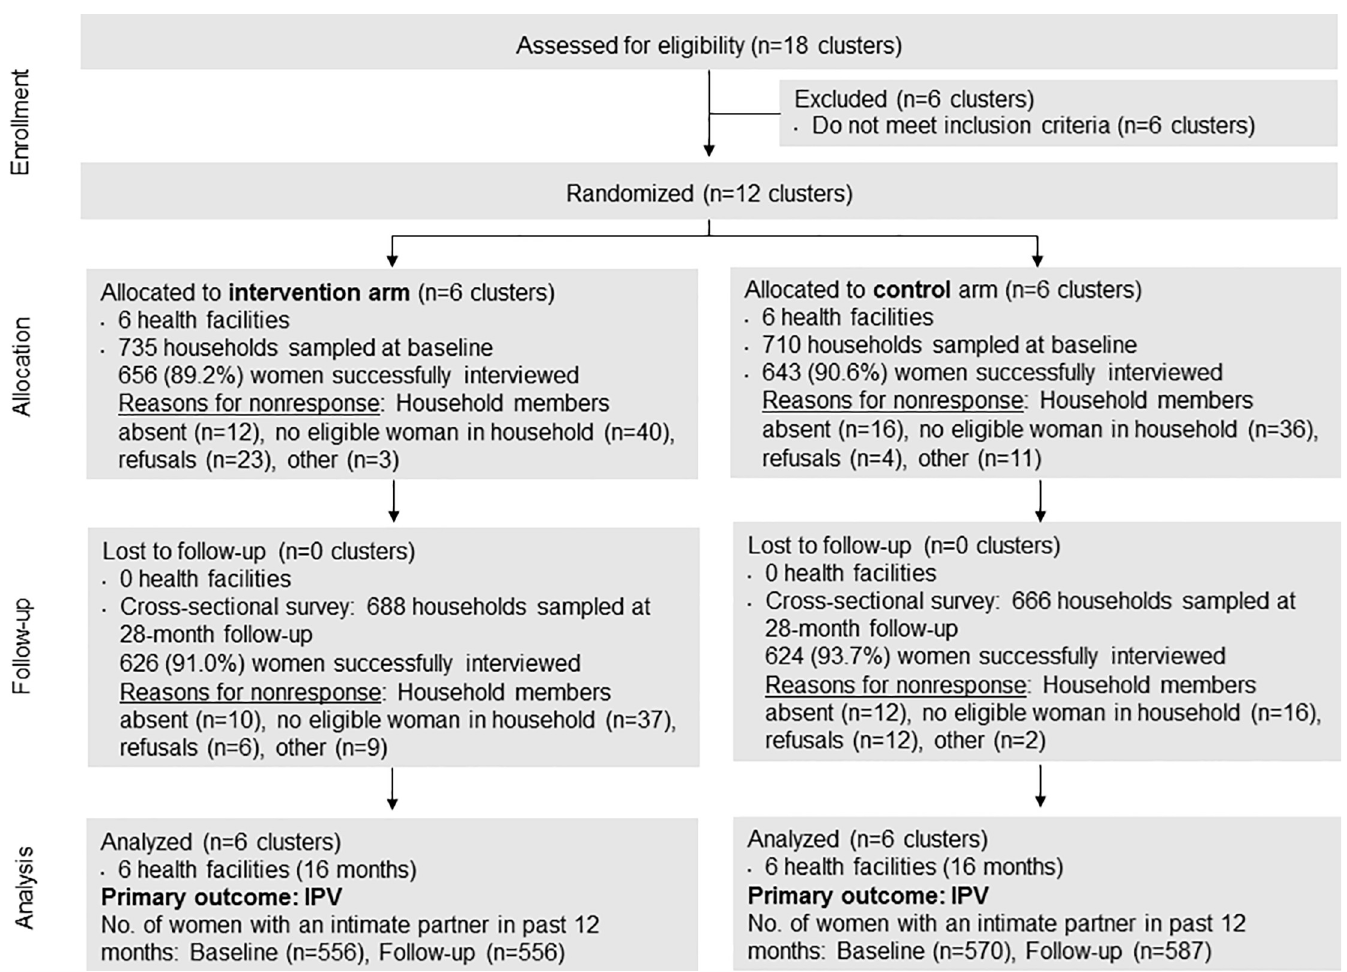
Fig 1. Progress of clusters and individuals through phases of the Tathmini GBV cluster randomized